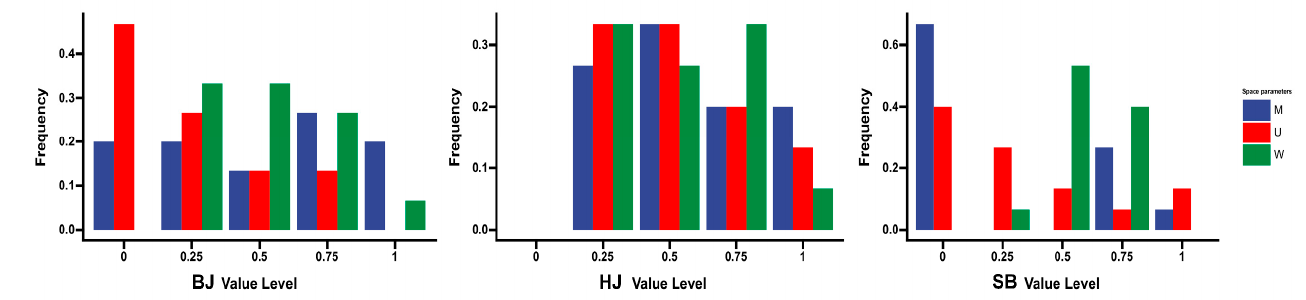
Figure 9. Spatial structure of HG. The W stands for angular scale, M stands for mixing degree, and U stands for the size ratio.